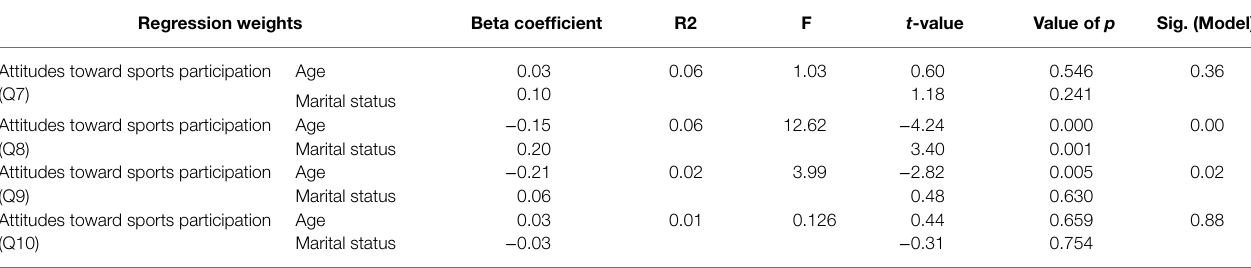
TABLE 5 | Multiple regression model (age and Marital status as predictors with attitudes toward sports participation). Regression